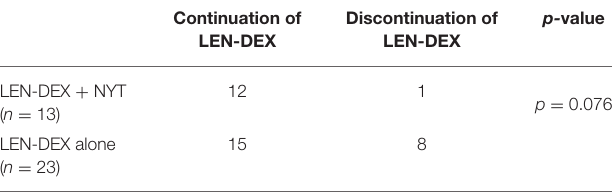
TABLE 3 | Continuation of LEN-DEX